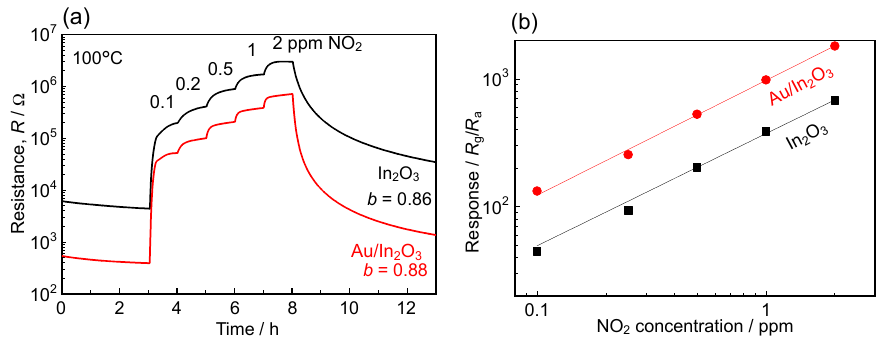
Figure 6. ( a ) Response transients to NO 2 (0.1–2 ppm) and ( b ) concentration dependences of NO 2 response of the In 2 O 3 and Au/In 2 O 3 sensors at 100 °C in wet air (70%RH at 25 °C).